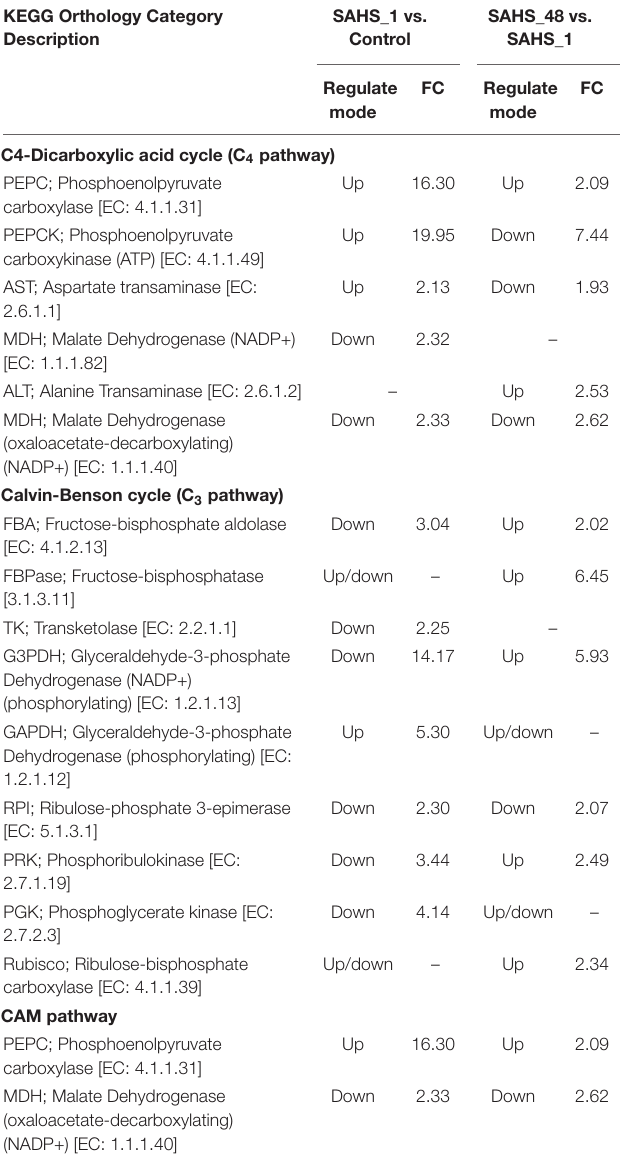
TABLE 5 | The up and downregulated genes related to the carbon fixation pathways during SAHS Stage transitions. KEGG Orthology Category Description